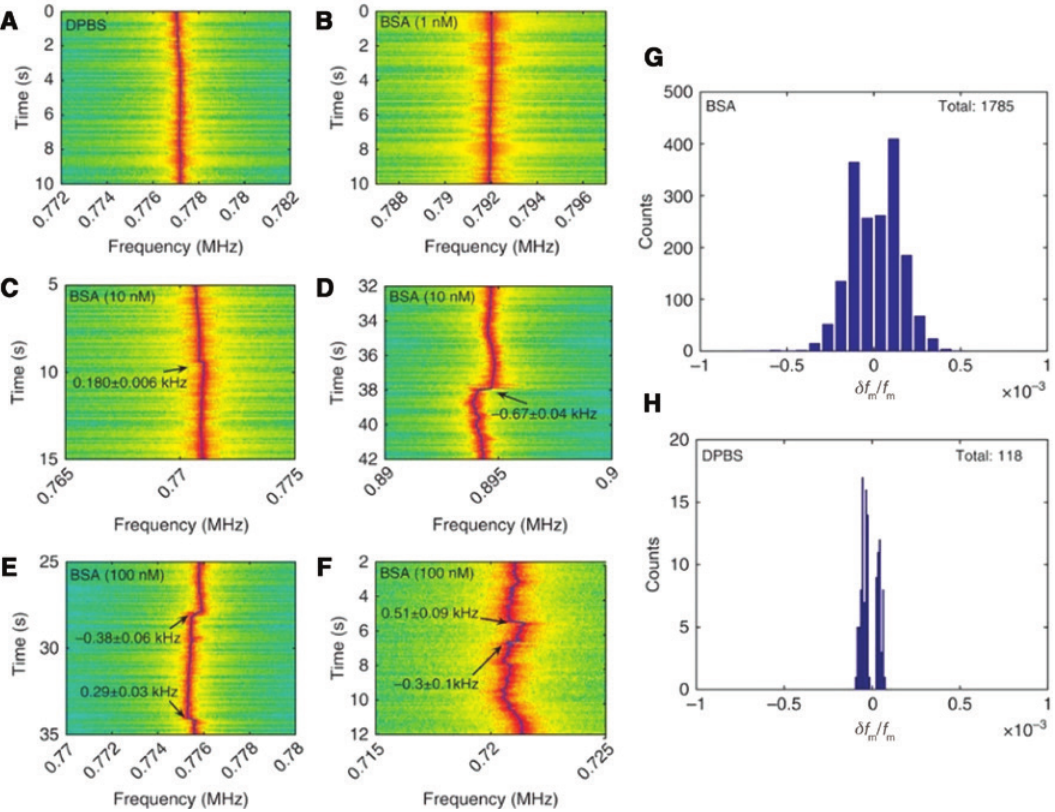
Figure 9: Sample mechanical spectrograms for a third harmonic tone and different BSA protein concentrations. (A) Expected spectrogram for Dulbecco’s phosphate-buffered saline (DPBS) as the external dielectric, without BSA. (B) Spectrogram for 1 nm of injected BSA, without binding events. (C) and (D) Spectrograms for 10 nm of injected BSA, with 180 ± 6 Hz binding and −670 ± 40 Hz release events, respectively. (E) and (F) Spectrograms for 100 nm of injected BSA, with several binding events wherein some exhibit fre- quency and background noise increasing over time. (G) and (H) Respective histograms of normalised frequency steps for BSA binding and the bare DPBS control. Reprinted from